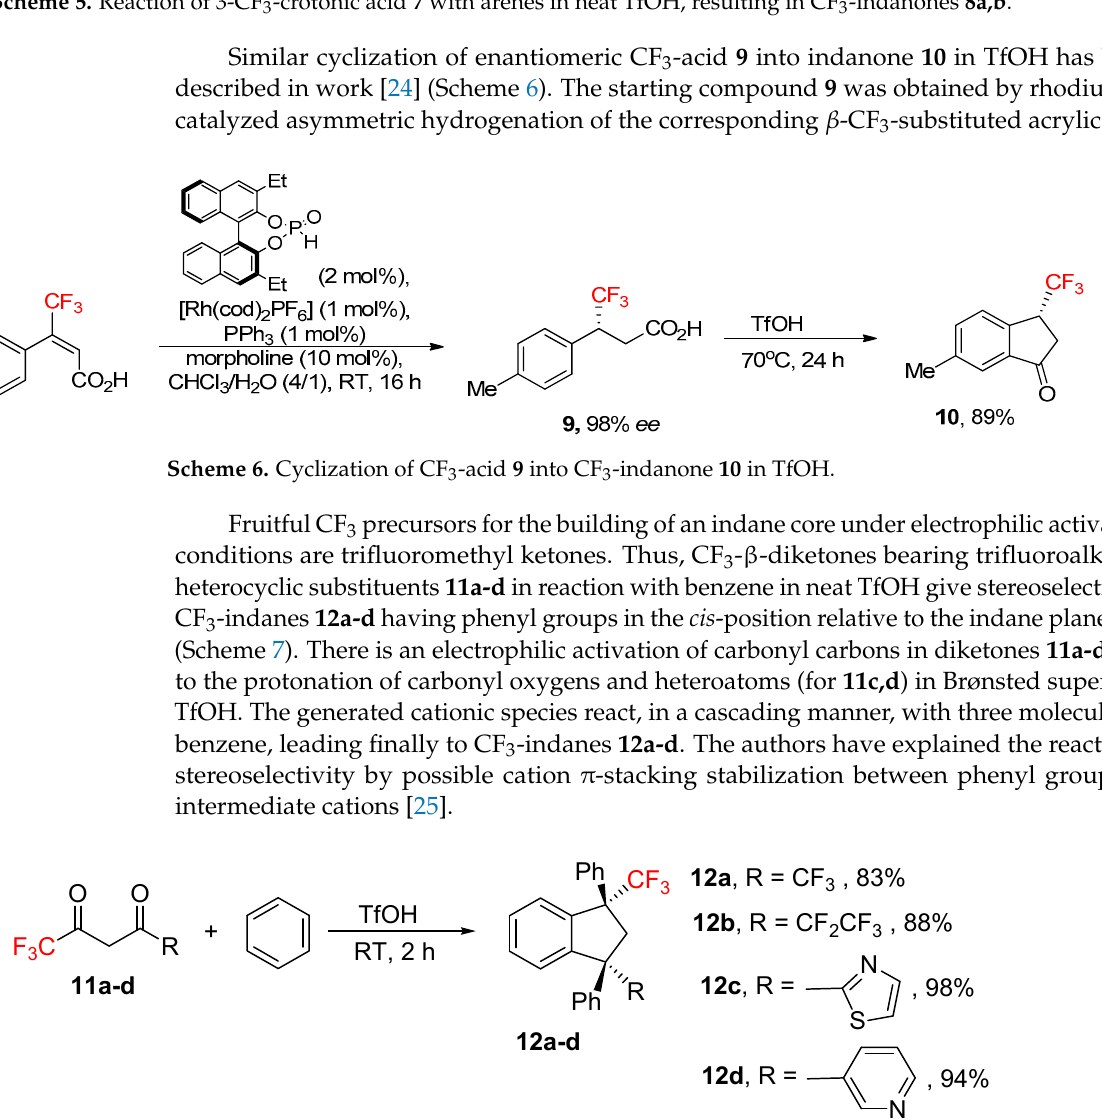
Scheme 7. Synthesis of 1-CF 3 -indanes 12a-d by reaction of CF 3 - β -diketones 11a-d with benzene in TfOH.